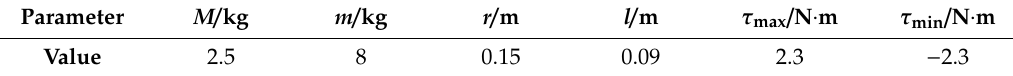
Table 1. Main physical parameters of the spherical robot.